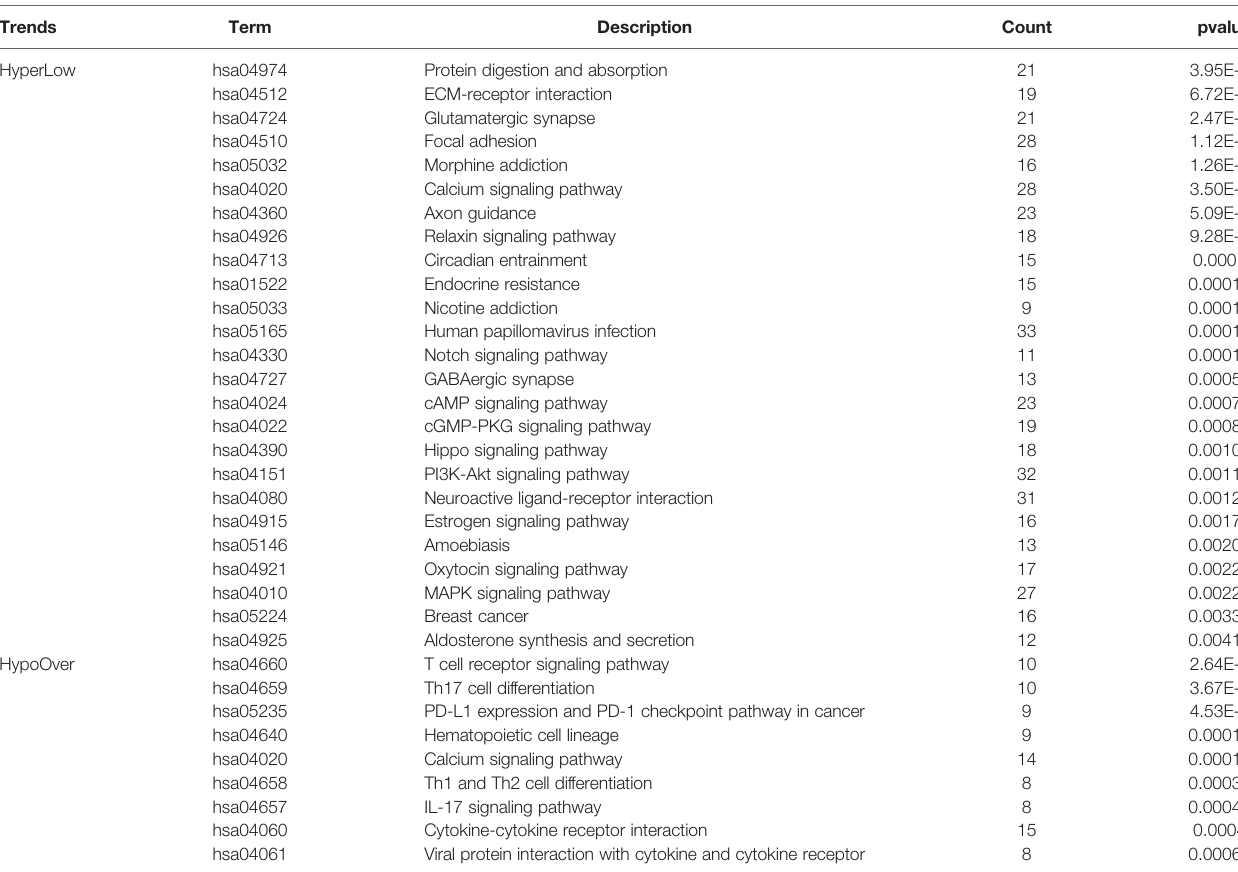
TABLE 1 | Functional analysis of DNA methylation regulatory